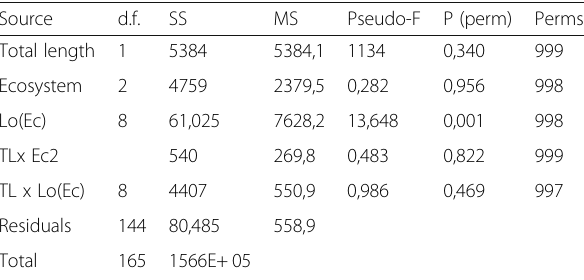
Table 2 Summary of PERMANOVA of the composition of metazoan parasite infracommunities in 166 G. maculatus according to their total length (TL), type of ecosystem (Ec) and sampling location (Lo)